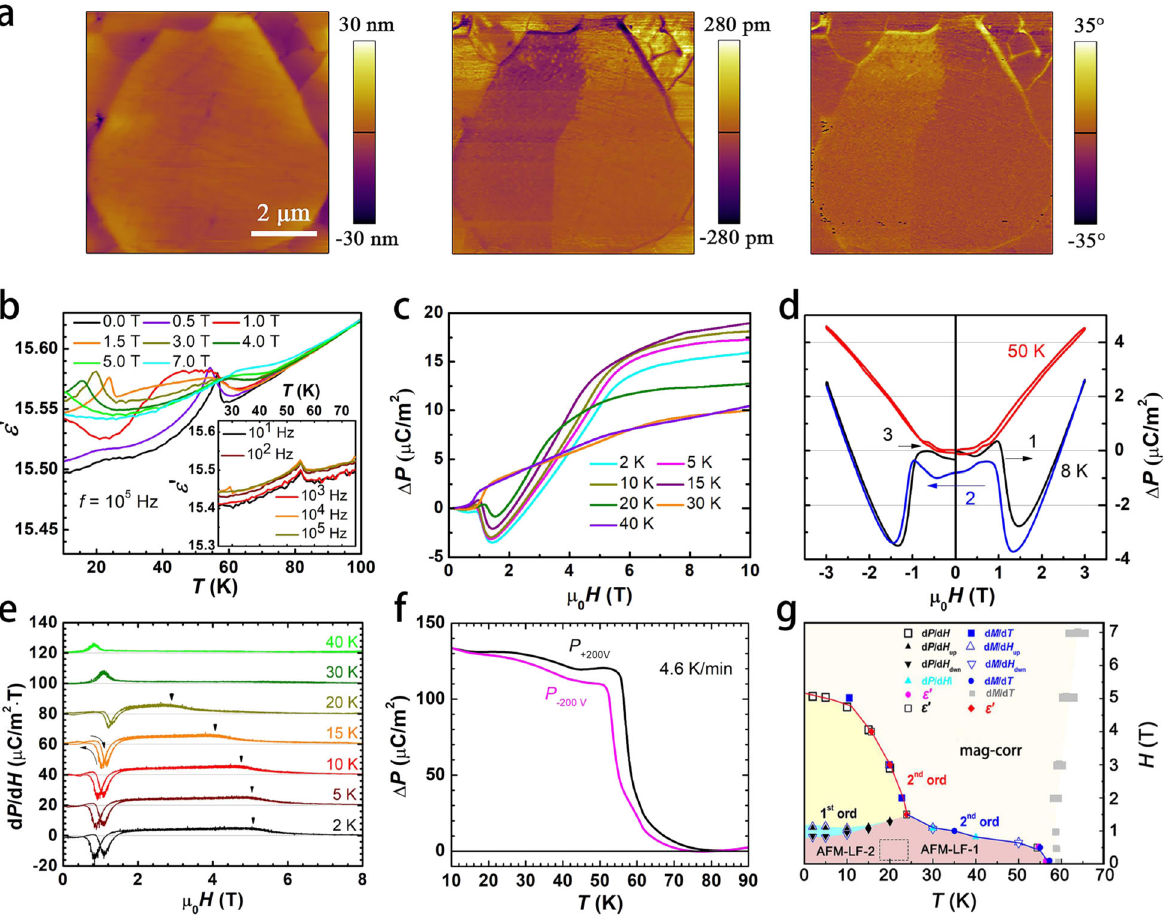
Fig. 5 The polar-nature-related physical properties of HP-CTO. a Piezoelectric performances: the topography (left), amplitude signal (middle), and phase image (right) of the out-of-plane piezoresponse. b Temperature dependence of dielectric constant at various magnetic fi elds. Inset shows the dielectric constant at different frequencies. c Temperature dependence of electric polarization. d , e Magnetic fi eld dependence of the electric polarization at various temperatures. For c , the data were obtained upon sweeping the magnetic fi eld up. f The d P / d H – μ 0 H plots derived from c , which has a non-hysteretic peak at ≥ 30 K, indicating a second-order phase transition. At lower T , we see two features: a minimum that clearly shows hysteresis and a step that shifts toward higher fi elds at low temperatures. g A schematic low temperature H – T magnetic phase diagram based on the M – H , P – H , M – T , and ε – T measurements. The detailed discussion and justi fi cation of the electrical and magnetic measurements and indicators of the transitions in the phase diagram are discussed at greater length in